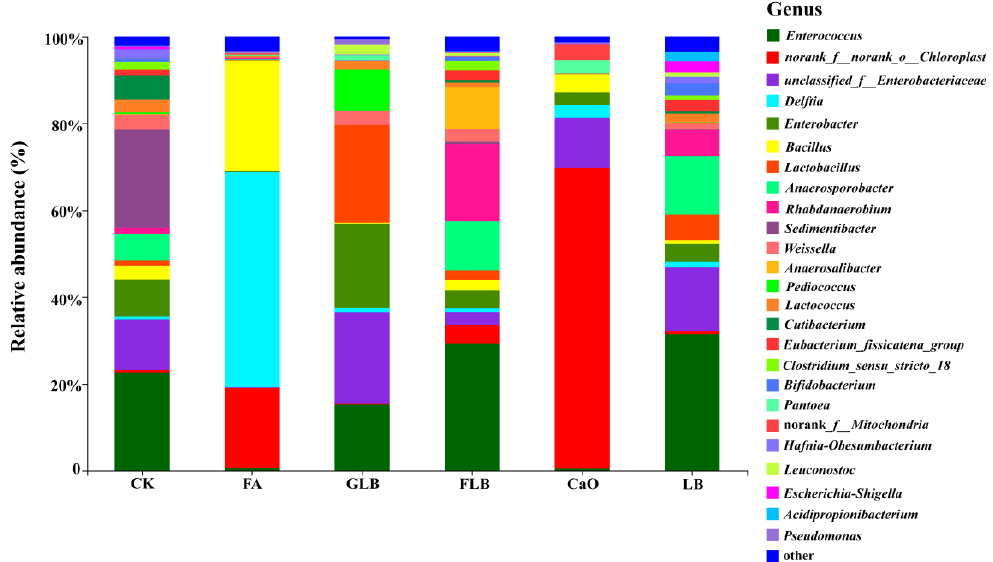
Figure 4. Bacterial communities and relative abundances at the genus level in alfalfa silage after 60 days of fermentation. CK, control, no additive; FA, 0.6% formic acid; CaO, 3% calcium oxide and 3% urea; LB, 1 × 10 6 cfu/g L. buchneri ; GLB, 2% glucose and 1 × 10 6 cfu/g L. buchneri ; FLB, 2% fucoidan and 1 × 10 6 cfu/g L. buchneri .